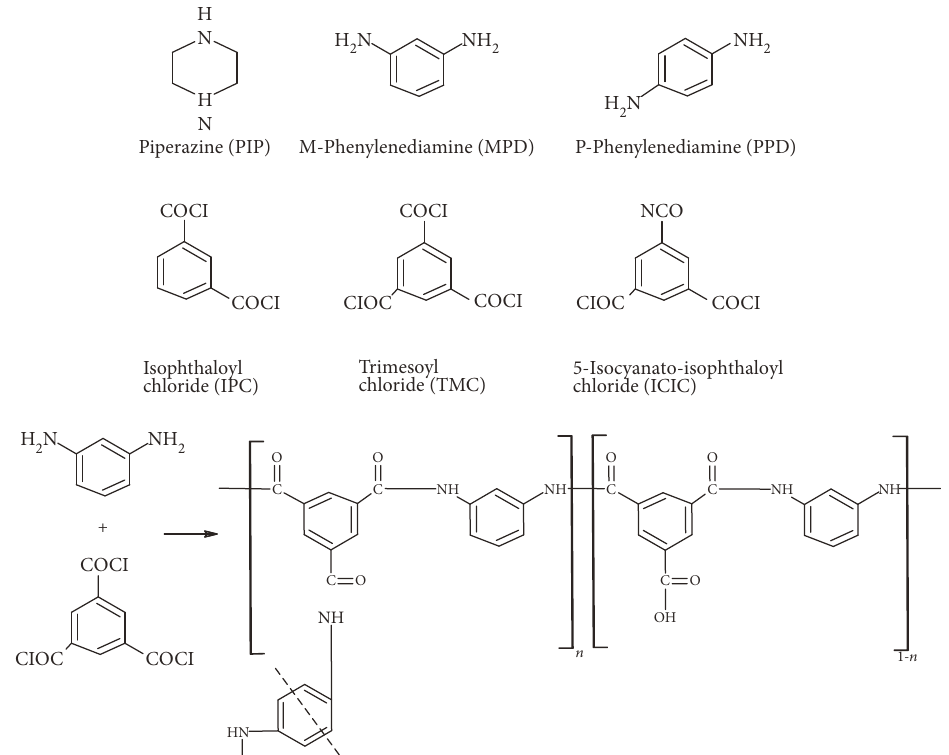
Figure 3: The examples of substances commonly used in the in situ interfacial polymerization process. PIP, MPD, and PPD are dissolved usually in deionised water and IPC, TMC, and ICIC in organic solvent like hexane. Beneth presented typical reaction between MPD and TMC [18,